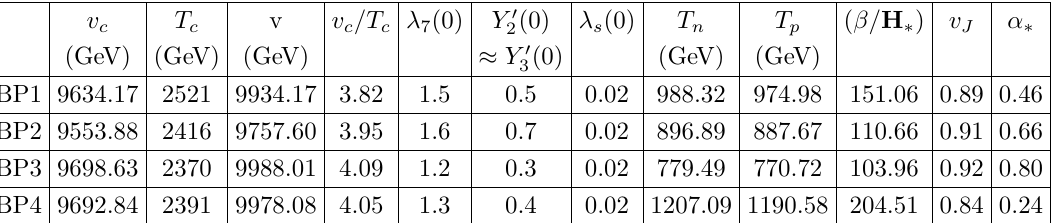
Table 3 . Benchmark parameters and other details involved in the GW spectrum calculation of the hybrid